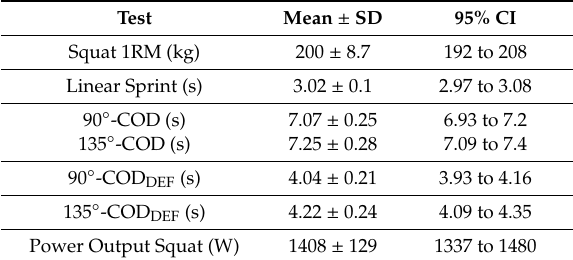
Table 1. Descriptive data for all measured